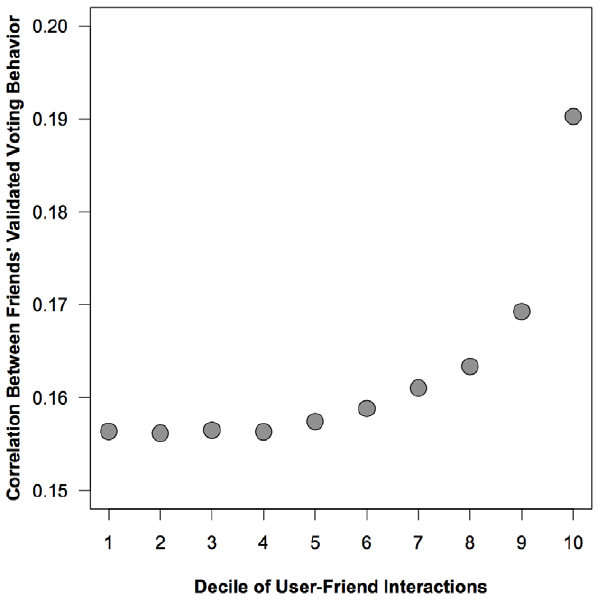
Figure 6. The correlation between friends’ validated voting behavior based on the proportion of interaction between the dyad in the three months prior to the election. We categorized all friendships in our sample by decile, ranking them from lowest to highest percent of interactions. Each decile is a separate sample of friendship dyads. For example, decile 1 contains all friends at the 0th percentile of interaction to the 10th percentile while decile 2 contains all friends at the 11th percentile of interaction to the 20th, and so on. Interactions include actions on Facebook that could be directed from one user to another and include: comment, like, message, poke, wall post, tag or chat. These correlations exist well outside of simulated null distributions. 95% confidence intervals are displayed in Table